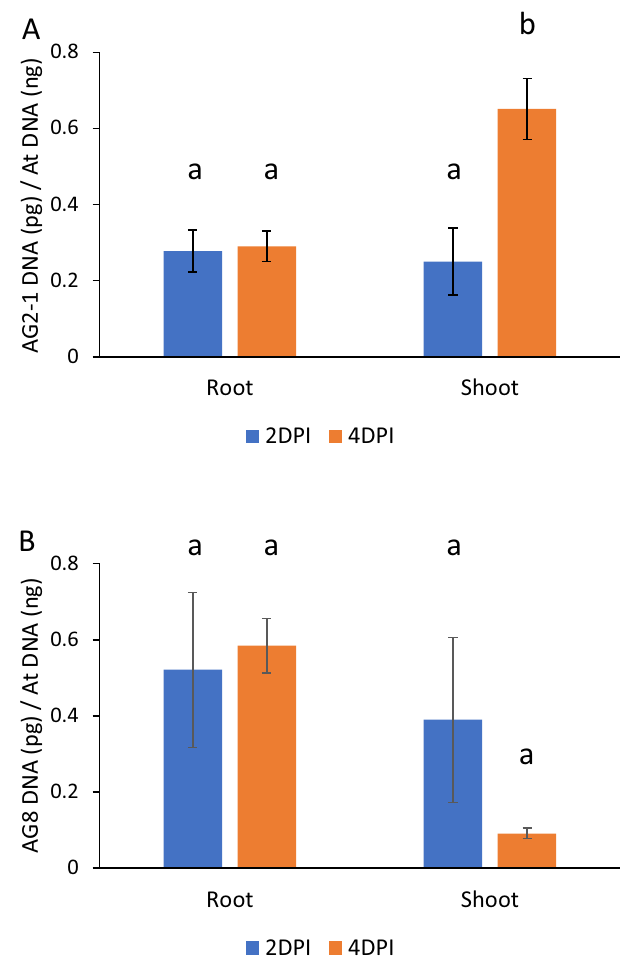
Figure 4. Quantification of ( A ) AG2-1 and ( B ) AG8 biomass in A. thaliana Col-0 roots and shoots using qPCR. Col-0 plants were inoculated by planting the roots directly into infected vermiculite. After DNA extraction, pathogen DNA was amplified using R. solani ITS primer sequences and Arabidopsis DNA amplified using beta-Tublulin primer sequences. The Y-axis represents relative abundance of R. solani DNA (picograms) versus A. thaliana DNA (nanograms) determined using a standard curve derived from cultured R. solani tissue and A. thaliana genomic DNA. Bars with differing letters represent a significant difference ( p < 0.05) using a one-way ANOVA and Tukey’s HSD test. Six biological replicates of forty plants were used per treatment and timepoint. Error bars represent standard